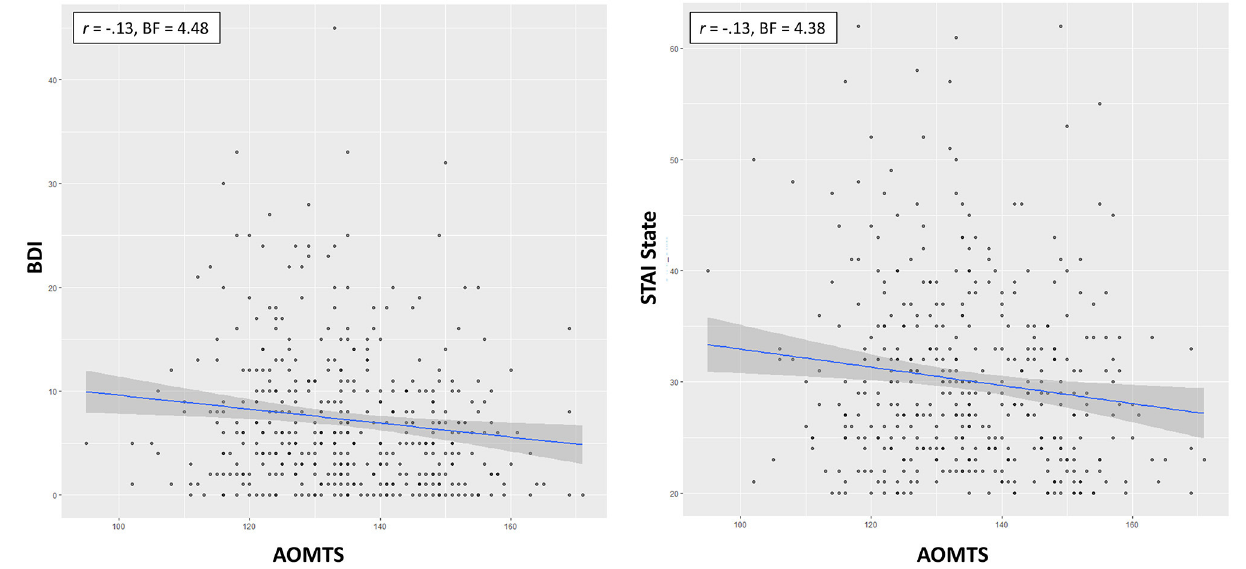
Frontiers in Psychiatry |